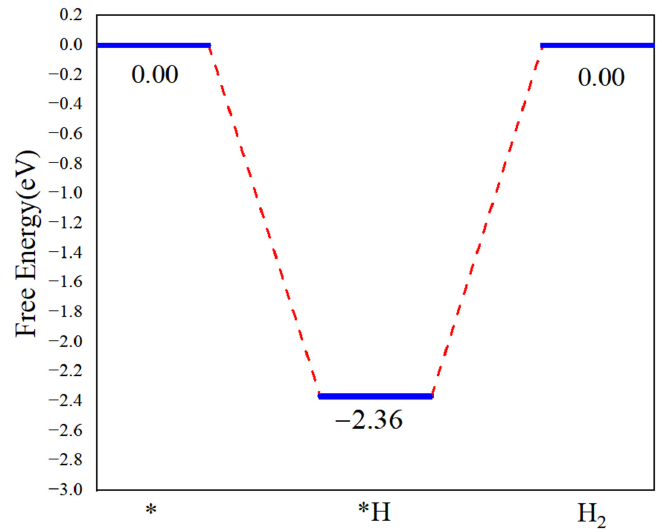
Figure 7. Free energy diagram for the HER on B2@C 3 N 4 . (Label * denotes the status of adsorption).